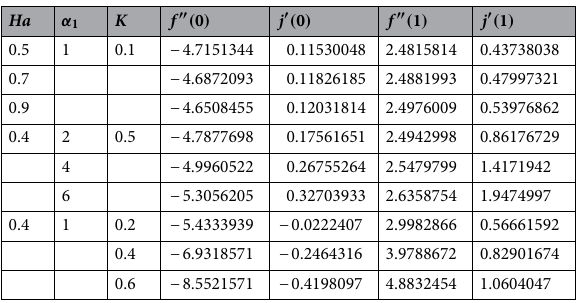
Table 2. Computational values of friction drag coefficient at both walls against the different estimation of Ha , α 1 and K